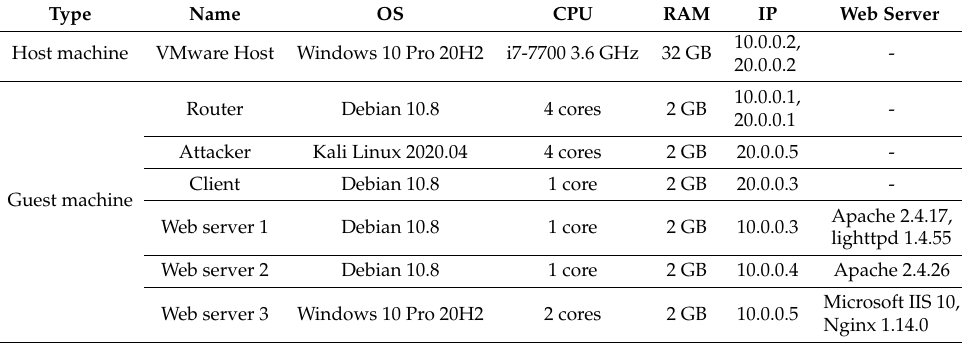
Table 6. Experimental network